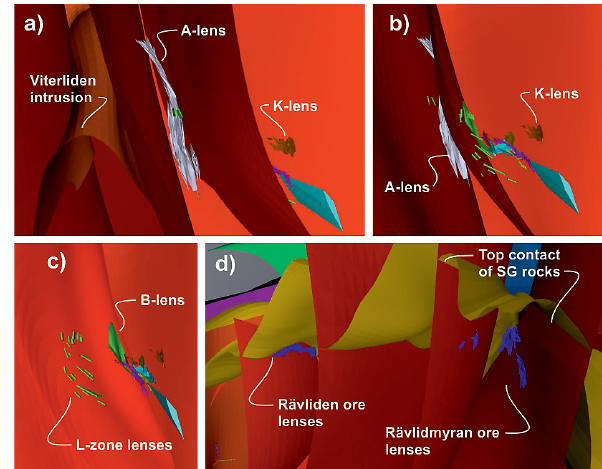
Fig. 11. Screenshots from the Supplementary 3-D PDF illustrating the geometry of the Kristineberg area VMS deposits. The surfaces in various shades of red are shear zones. (a–c) show the Kristineberg deposit viewed towards approximately E, with slight rotation from a view towards ESE in (a) towards ENE in (c) . (d) Rävliden and Rävlidmyran deposits viewed towards WSW. The grey, green and blue are structural form surfaces (see Supplement for